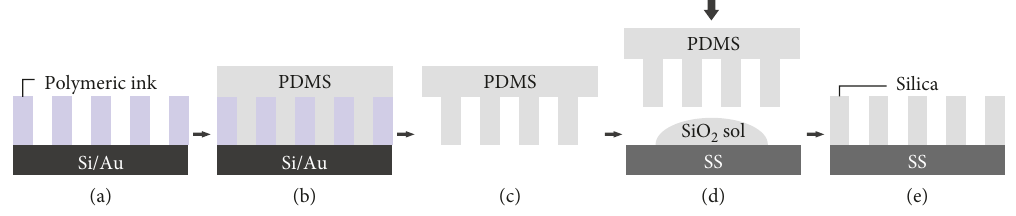
Figure 1: A: master pattern created through DPN. B: PDMS onto pattern. C: negative pattern duplicate in PDMS (microstamp). D: transfer to the SS316L substrate using silica sol. E: dot pattern in silica on incubated at 37 ° ± 1 ° C for 48 h, and then colony-forming units (CFUs) were counted. This entire process was repeated